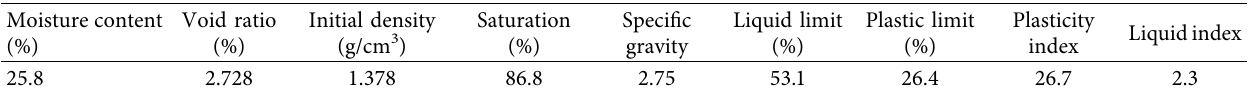
Figure 12: Volumetric strains versus creep time in the experiment and simulation for Shantou dredger fill: (a) σ ′ � 200kPa; (c) σ ′ � 300kPa. σ 3 3 Table 4: Fundamental characteristic indexes of the silted soil in front of